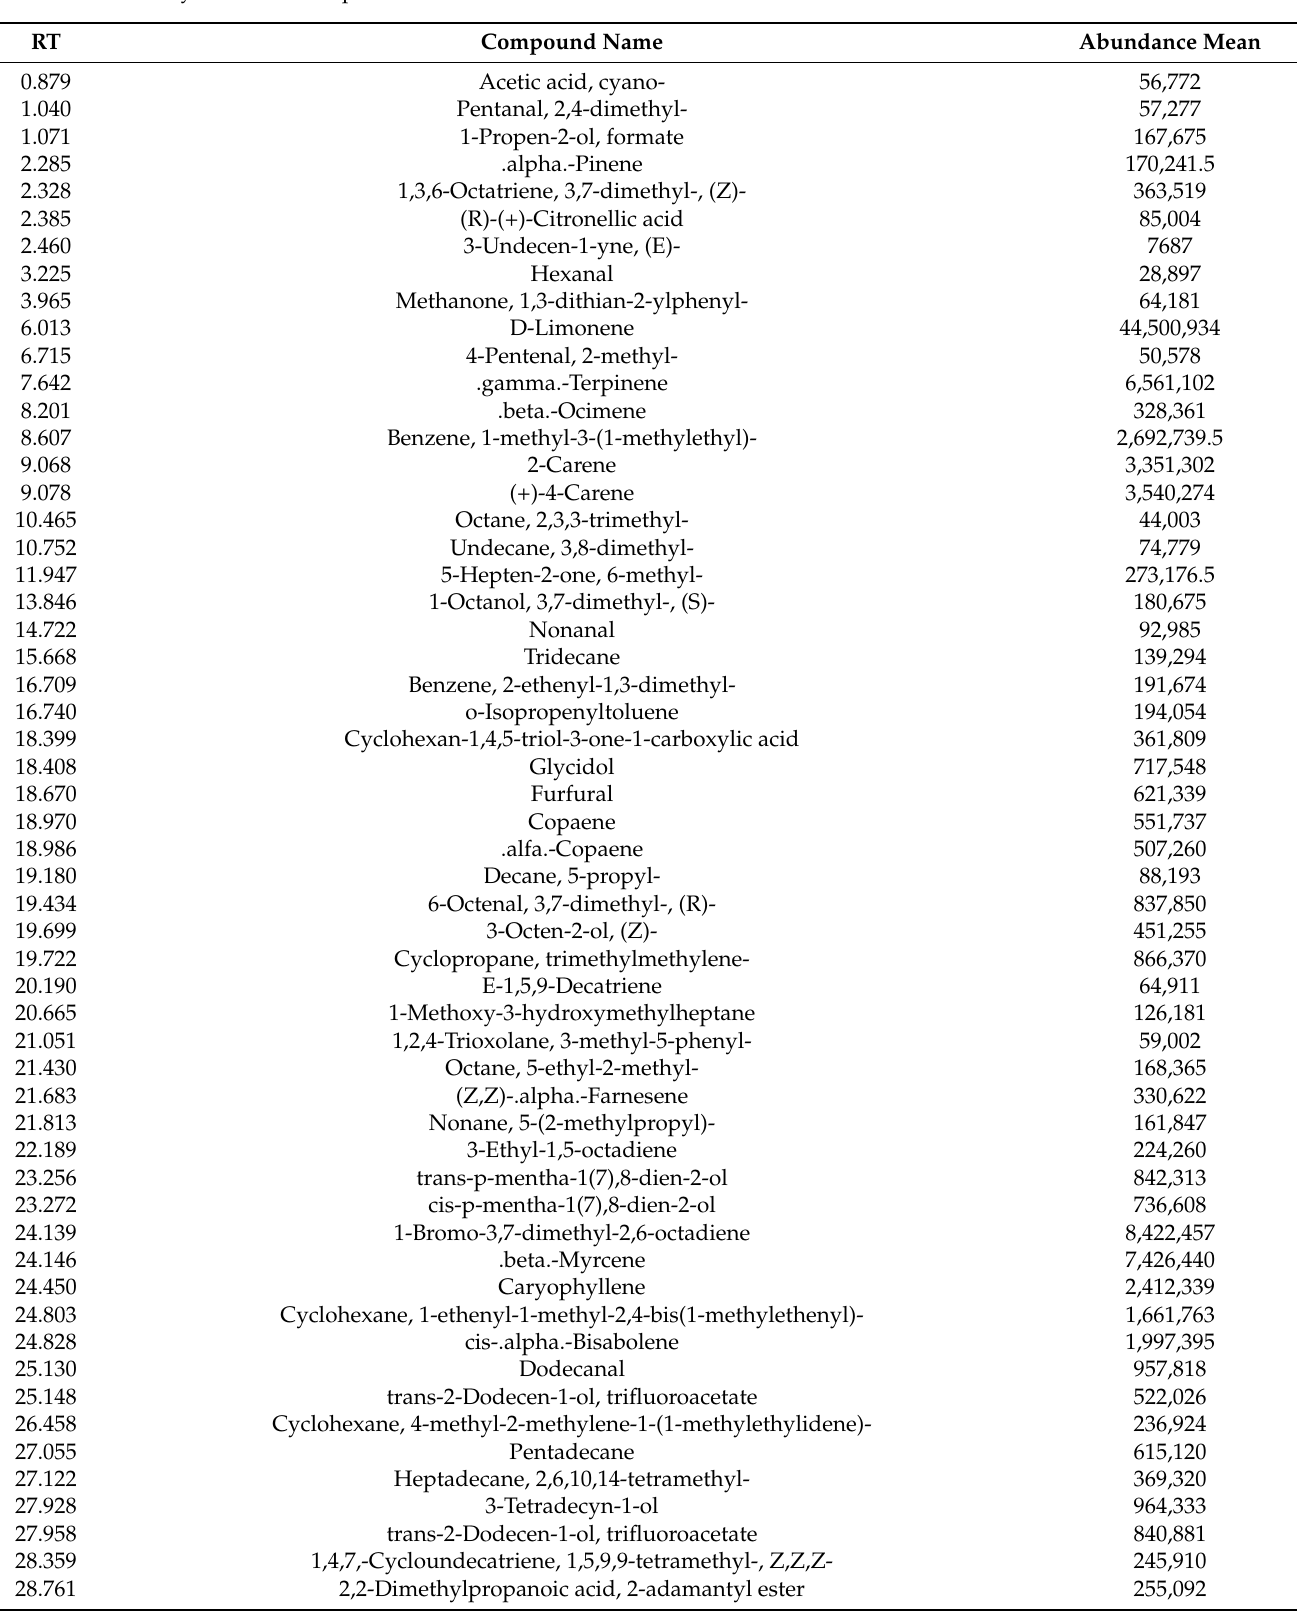
Table A3. Results for the SGL sample fingerprint determination with indication of the retention time (RT) and abundance mean for every identified